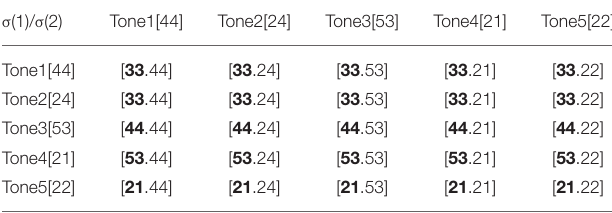
TABLE 6 | The relative pitch values of lexical tones in Xiamen disyllabic words. σ (1)/ σ